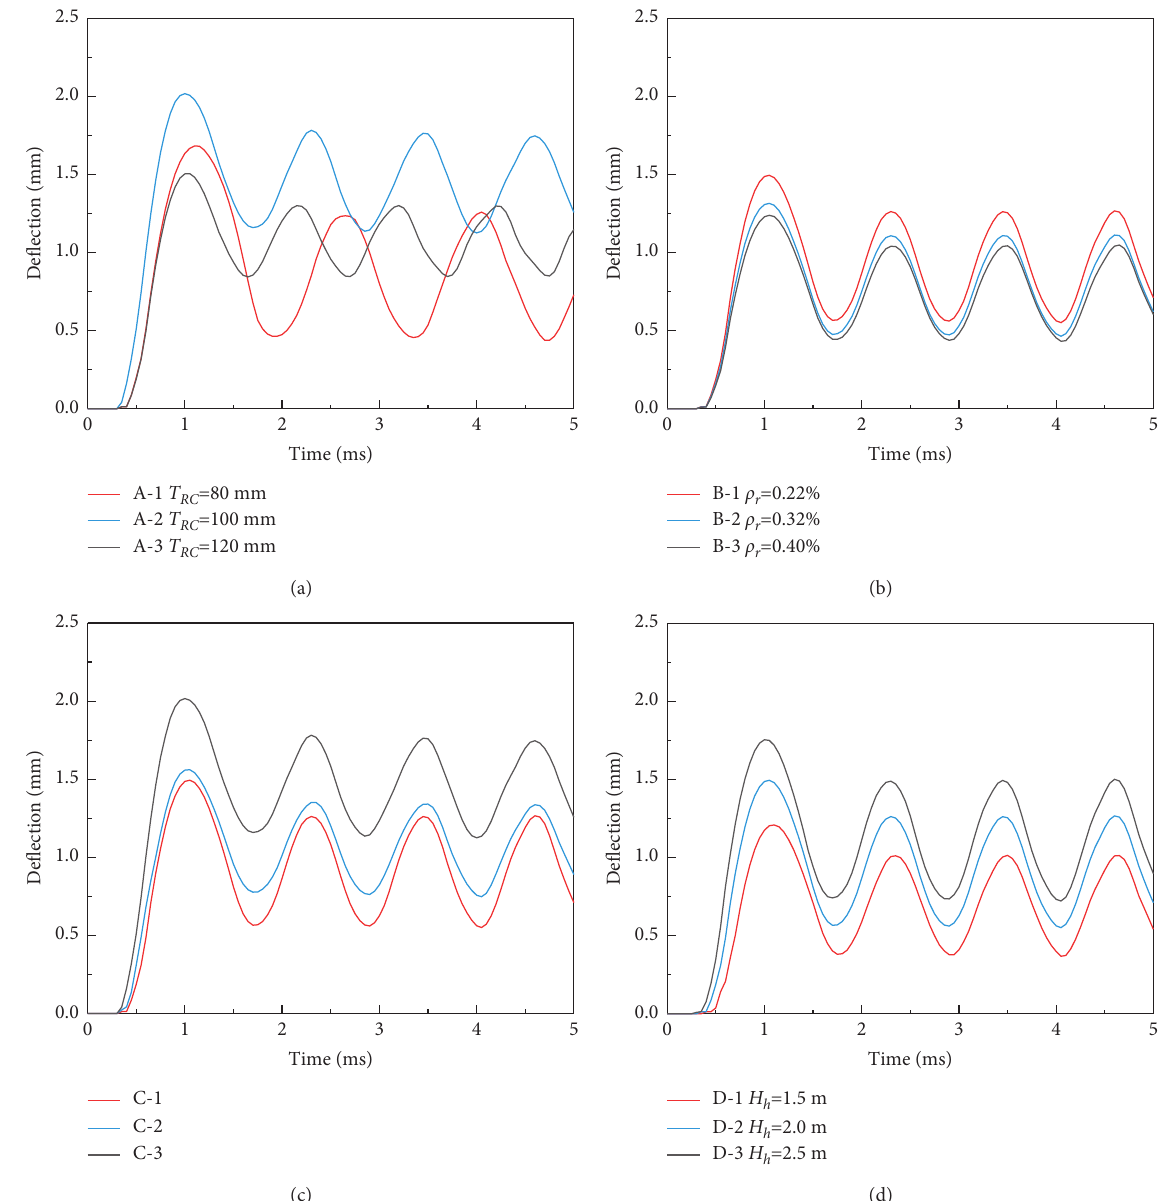
Figure 8: Time history curves of constrained force under the first